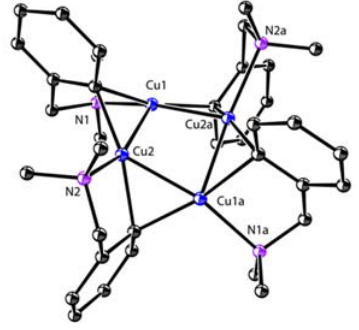
Figure 8. Molecular structure of 31 ; drawn based on [92].